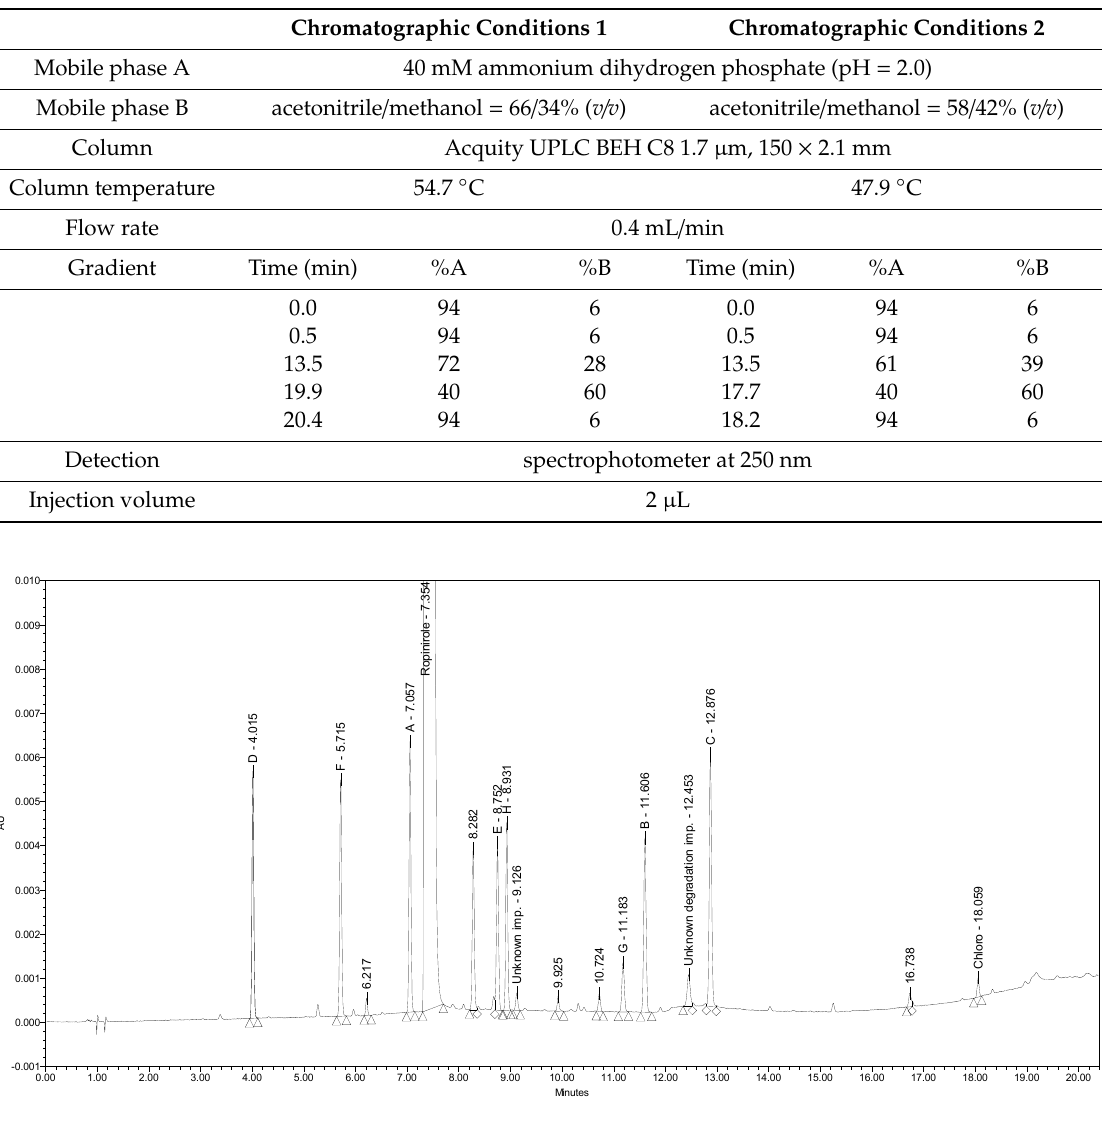
Figure 8. A chromatogram of ropinirole hydrochloride at a concentration of 0.5 mg/mL spiked with nine process-related impurities at the 0.2% level, including unknown impurity present in the sample (t R ≈ 9 min) and unknown degradation impurity (t R ≈ 13 min), obtained using chromatographic conditions 1.